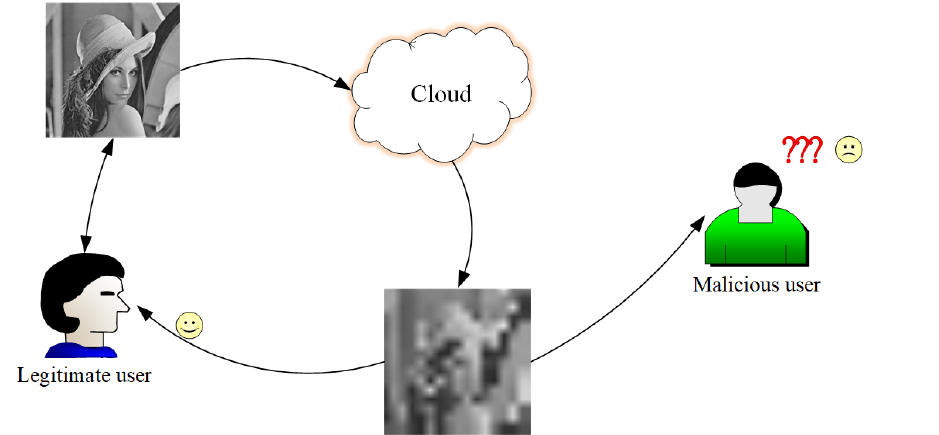
Figure 2. Thumbnail-preserving